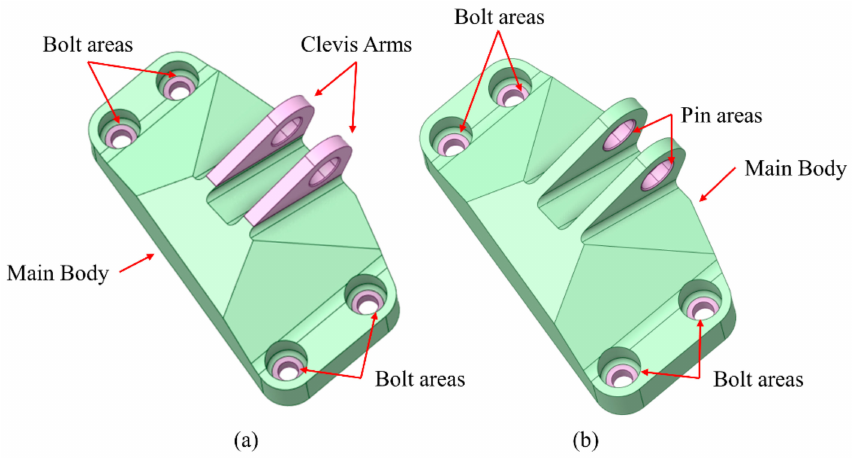
Figure 5. The multibody parts used both for the FEA, the optimizations, and the validation studies: ( a ) multibody part for the Lattice and TO_Lattice, and ( b ) multibody part for the LO, TO, and